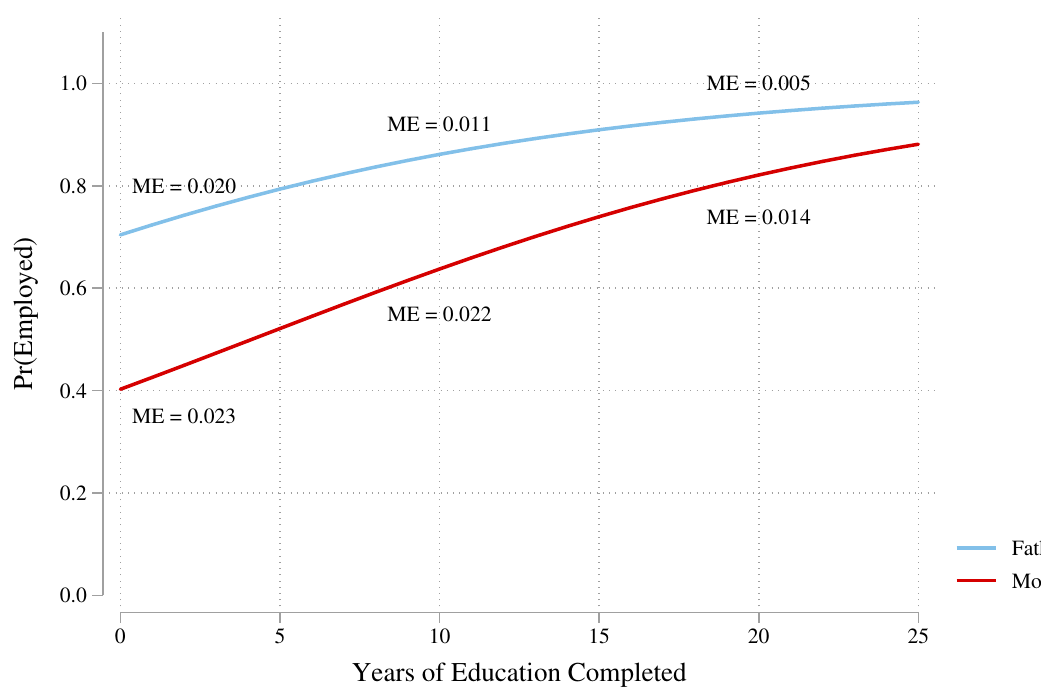
Figure 6: Predicted probability of being employed for mothers and fathers based on years of education completed: intercept shift example (no interaction term in the